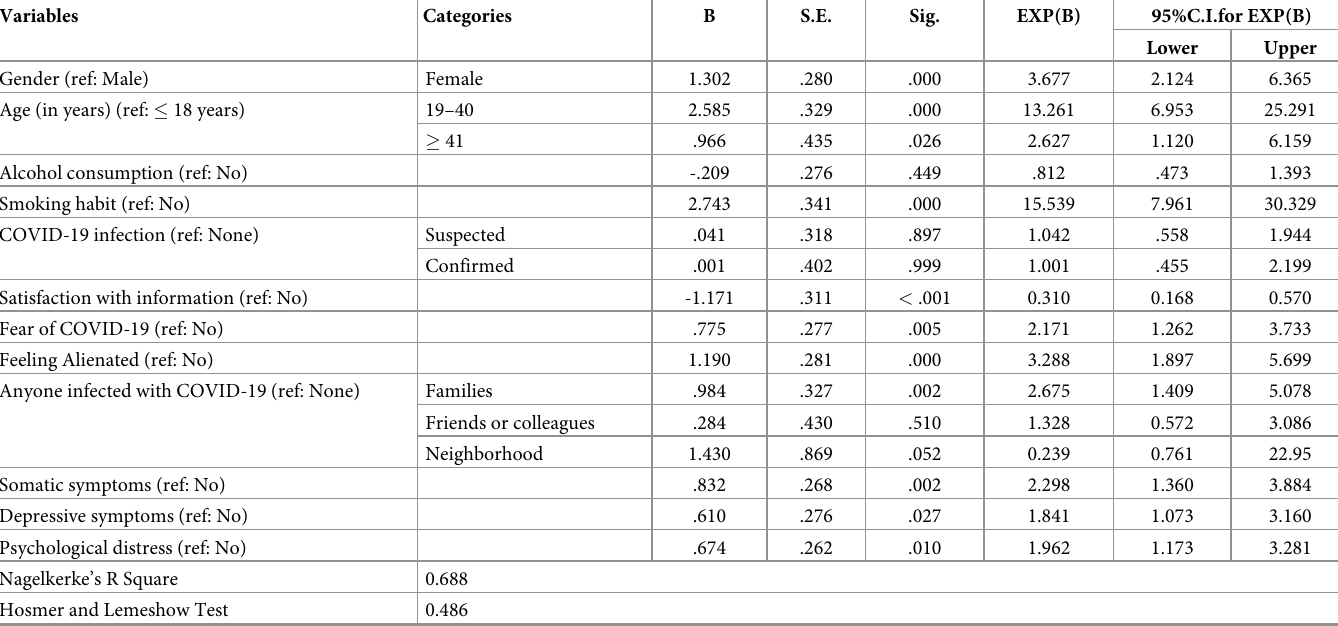
Table 3. Multivariable binary logistic regression result for insomnia among Mettu town residents, southwest Ethiopia.